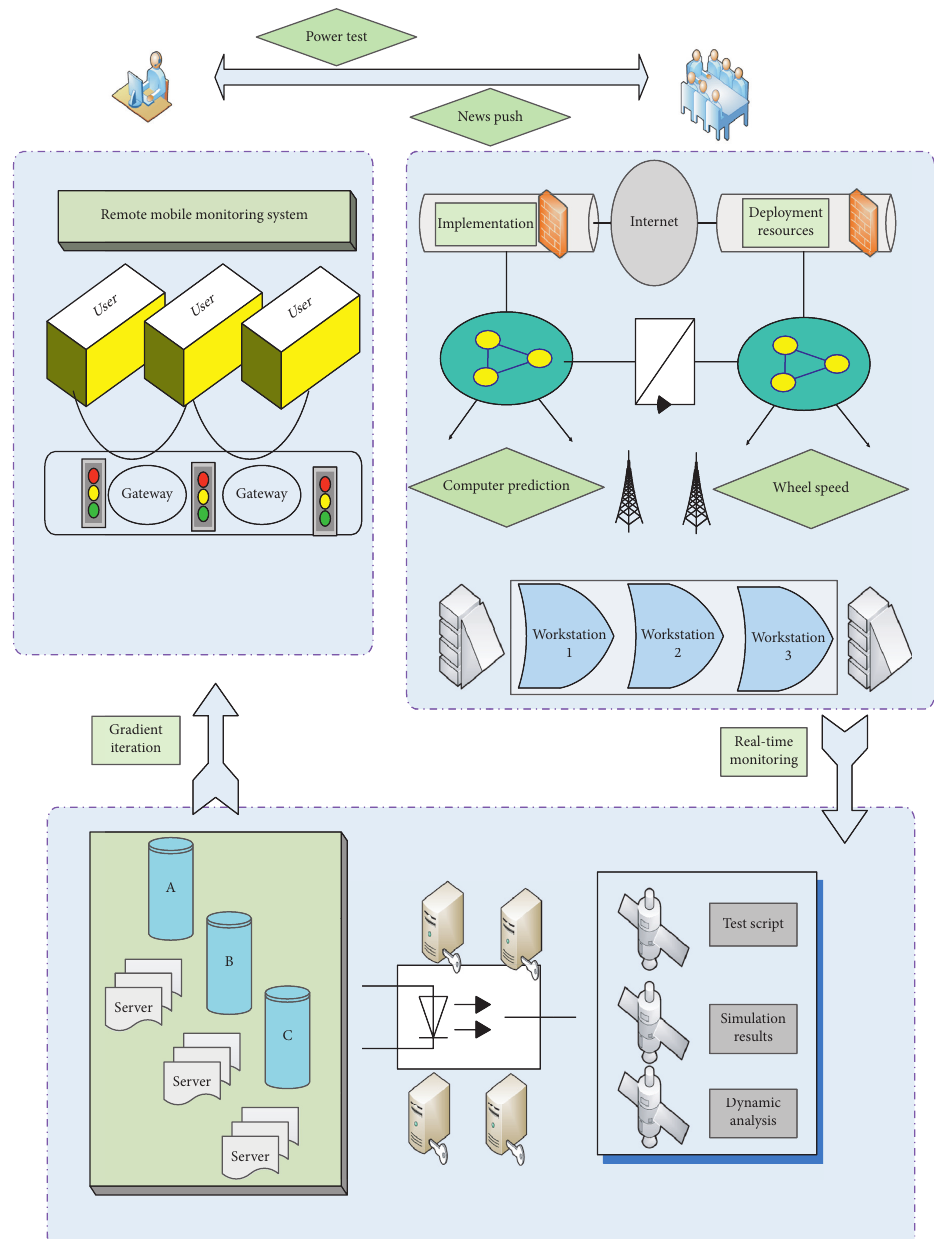
Figure 4: The model framework of the wind power generator speed computer monitoring